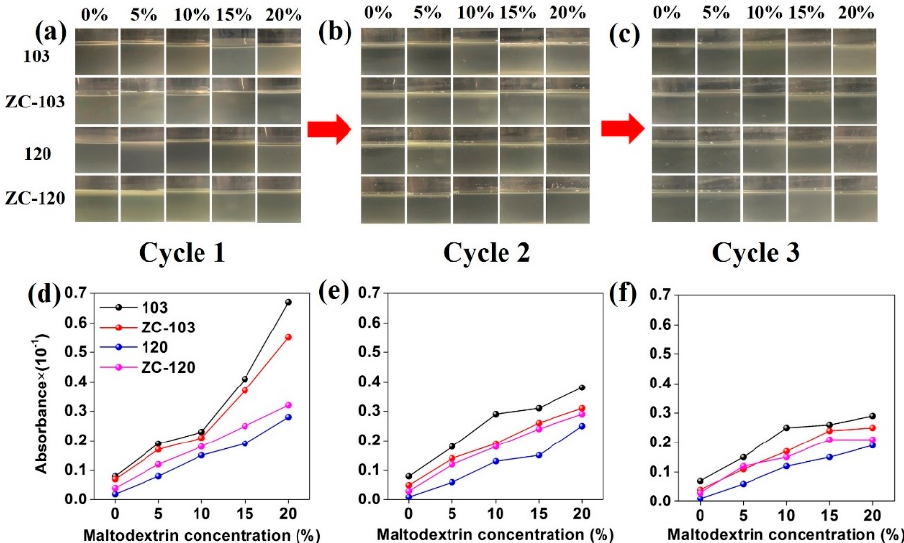
Figure 5. Changes in the immersion liquid after the leaching cycles ( a – c ); absorbance of the liquid after the leaching cycles ( d – f